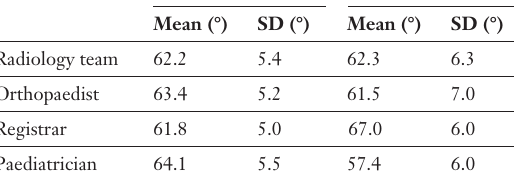
Bland/Altman angle analysis for the paediatrician and the registrar with mean difference, 95% CI and limits of agree- ment low and